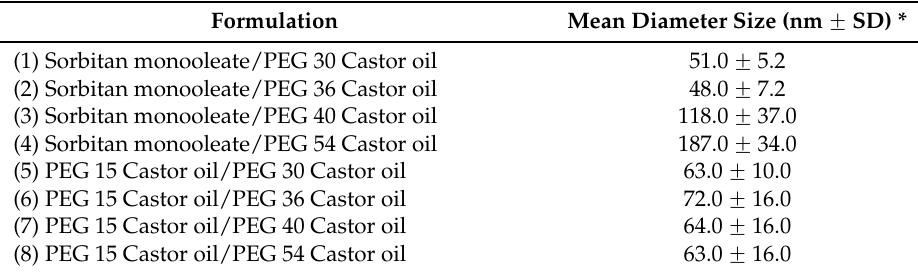
Table 2. Droplet mean diameter size produced with different pairs of surfactants (HLB = 9).